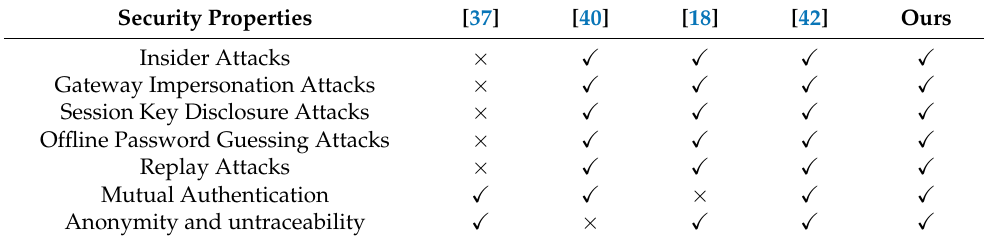
Table 3. Comparison of security.